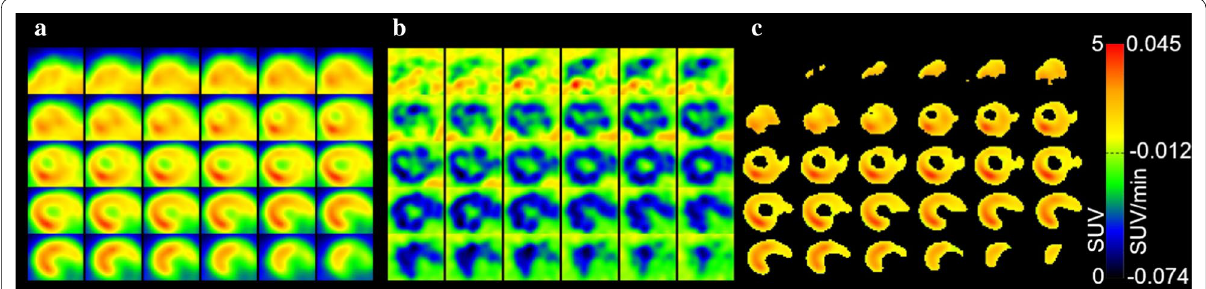
Fig. 1 Strategy for the definition of the volume-of-interest for myocardial [ 11 C]mHED uptake. a Transversal planes of a cropped volume including the heart, from posterior (top left) to anterior (bottom right). SUV 1–61 min according to colour scale. b Voxel-wise slopes SUV/time between 11 and 48 min p.i. Slopes according to colour scale. Voxels with slopes 0.012 SUV/min were excluded from the volume-of-interest, assuming spill-over ≥ − from liver (liver radioactivity was increasing over time). c From the remaining voxels, the volume with highest SUV between 3 and 11 min p.i., corresponding to 0.5% of the individual body weight (i.e. body weight (g) 0.005 cm 3 /g). Scan with 9.2 MBq [ 11 C]mHED (1.5 nmol/kg, including × metaraminol mass), body weight 27.6